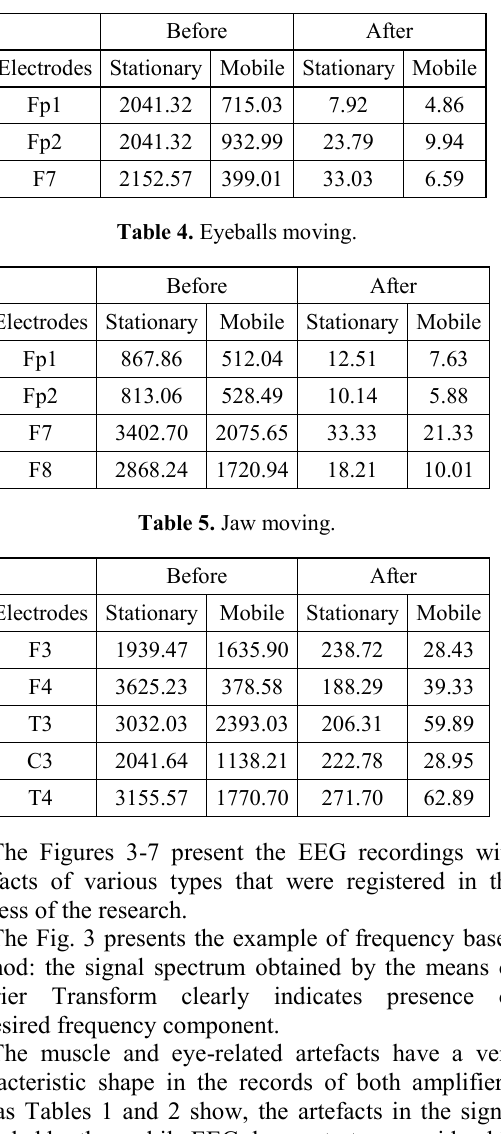
Fig 5 . Jaw moving. Top – original, bottom –